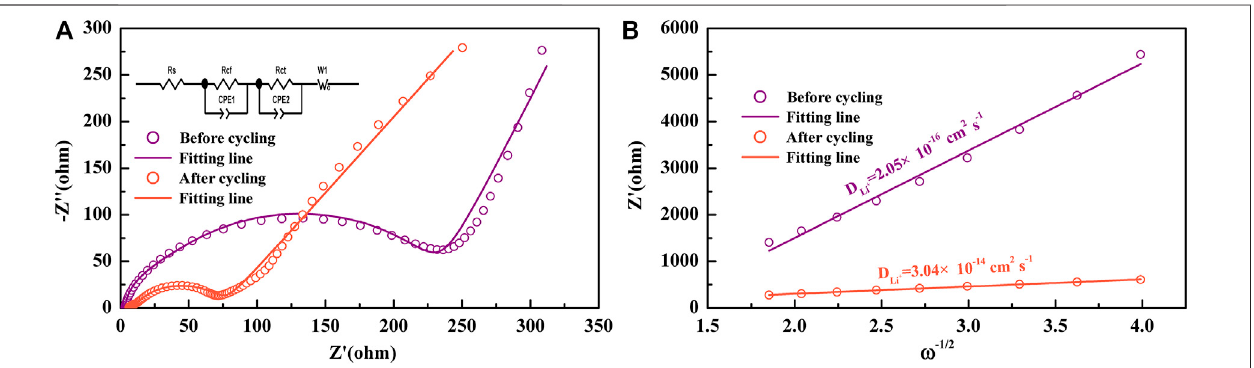
FIGURE5|(A) EISofNiSnanosphereelectrodesbeforeandaftercycles;theinsetistheequivalentcircuit. (B) Z ’ − ω − 1/2 plotsinthelow-frequencyrangeoftheNiS nanosphere electrodes before and after the cycling performance test.